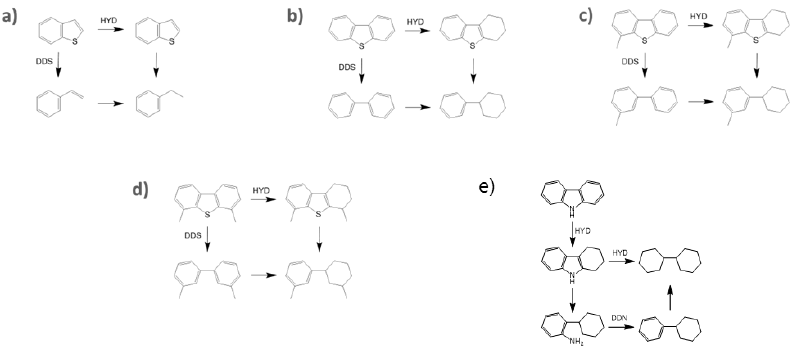
Figure 3. Reaction pathway for HDS of ( a ) benzothiophene (BT), ( b ) dibenzothiophene (DBT), ( c ) 4-methyl dibenzothiophene (4-MDBT), and ( d ) 4,6-dimethyl dibenzothiophene (4,6-DMDBT), and ( e ) HDN of carbazole (CBZ).